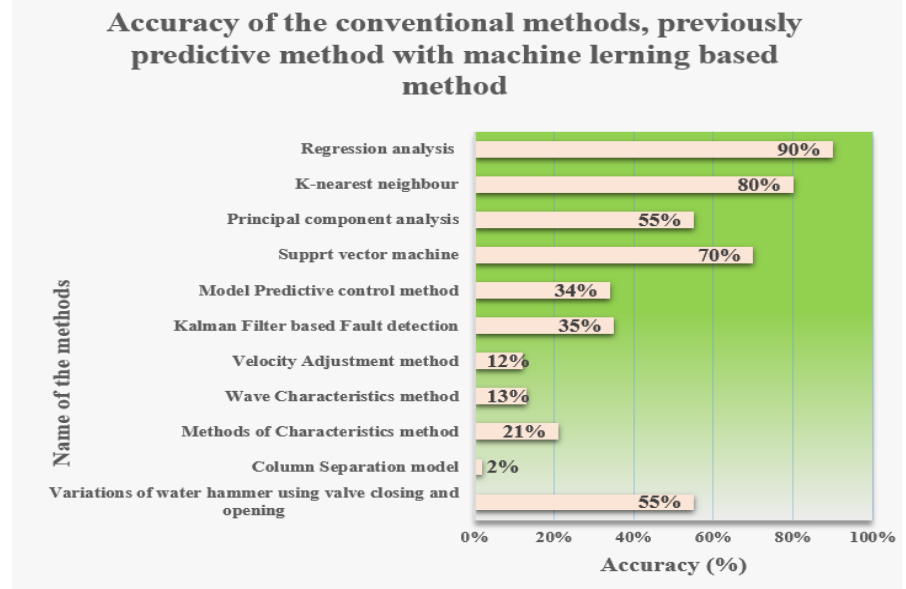
Figure 19. Comparison of various conventional and predictive control methods with ML-based predictive control method. predictive control